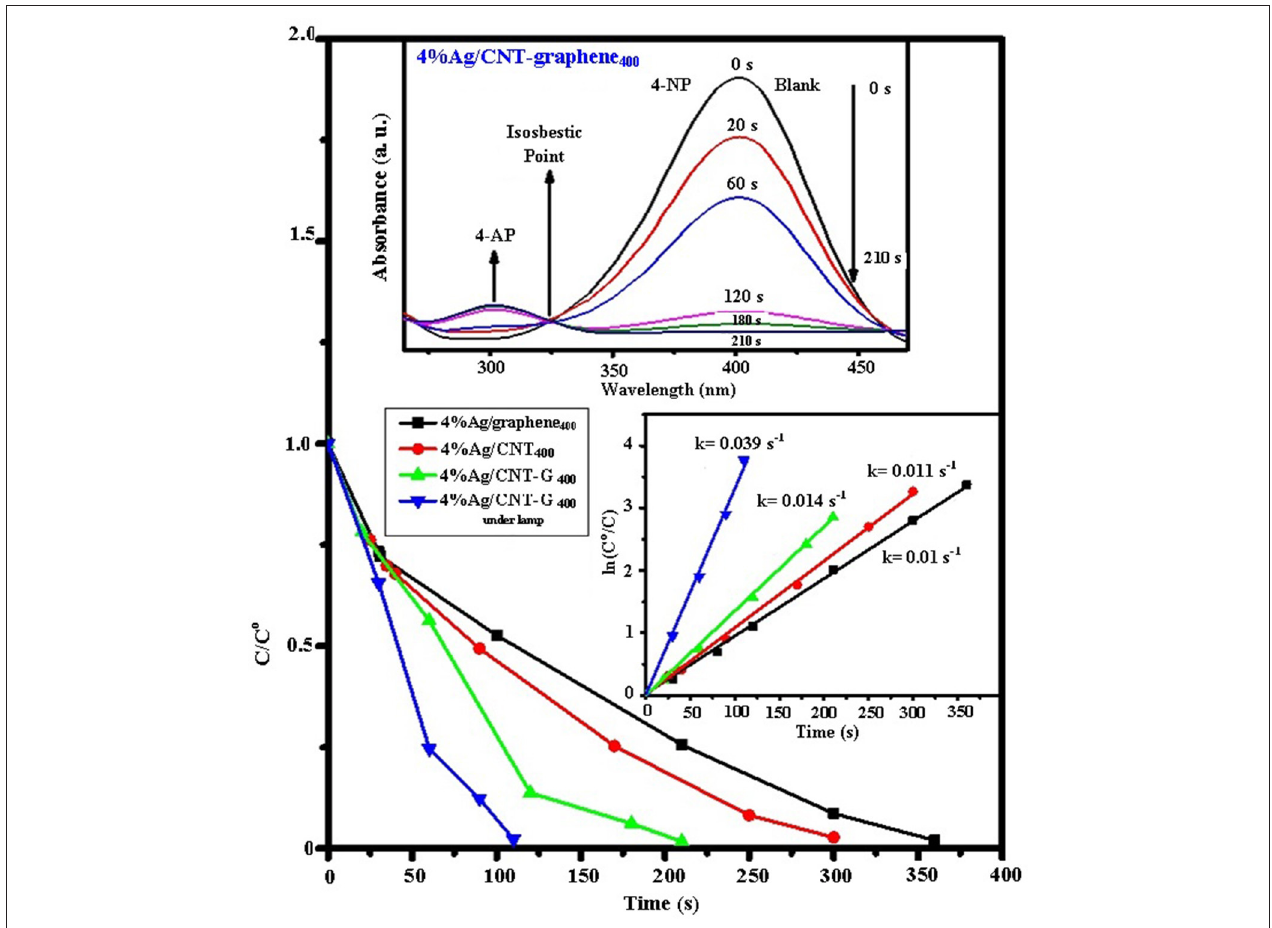
FIGURE 8 | C/C o vs. time for the hydrogenation of 4-NP over the different catalysts under dark and visible light and pseudo-first-order plots of ln (C o /C) against reaction time for the hydrogenation of 4-NP over the different catalysts (as inset). UV–vis absorption spectra of 4-NP before and after adding NaBH 4 and its reduction product 4-AP with time intervals on 4%Ag/CNT-graphene 400